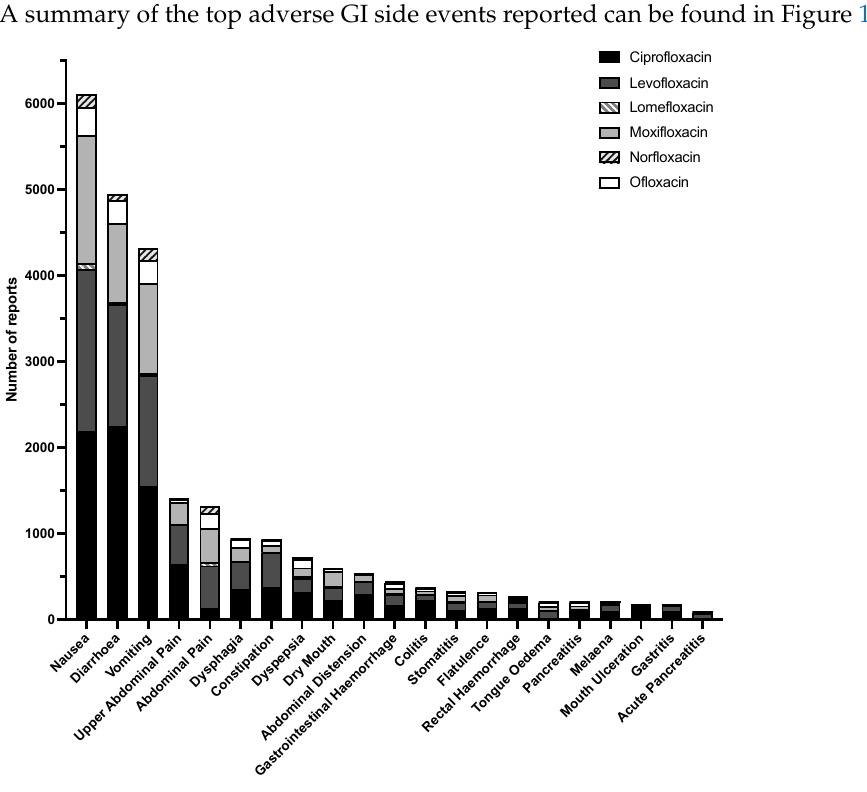
Figure 1. Gastrointestinal adverse events reported between 2004 and March 2021 in the FAERS database for ciprofloxacin (black), levofloxacin (dark grey), lomefloxacin (striped light gray), moxifloxacin (light gray), norfloxacin (striped dark gray), and ofloxacin (white).